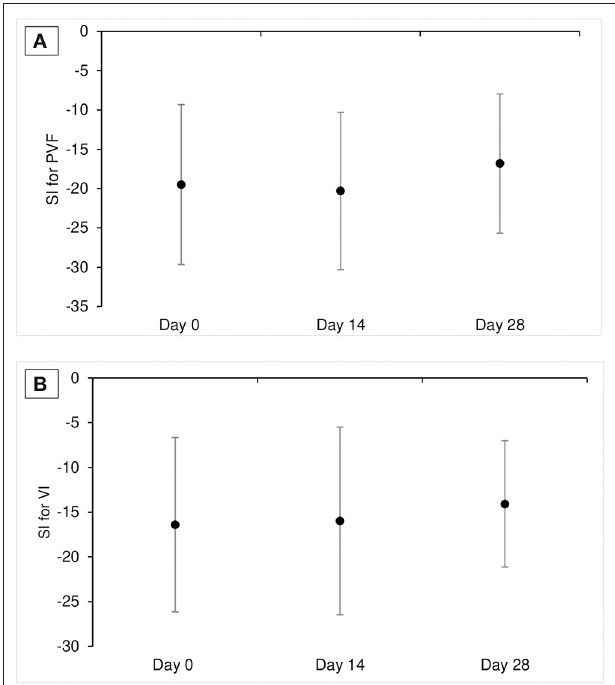
FIGURE 1 | Mean ± SD SI for PVF (A) and SI for VI (B) at each time point in Part A study ( n = 11). SI value of 0 means perfect symmetry between affected limb pairs and negative SI value means that the dogs put less weight on the affected limb. SI, symmetrical index; PVF, peak vertical force; VI, vertical impulse.